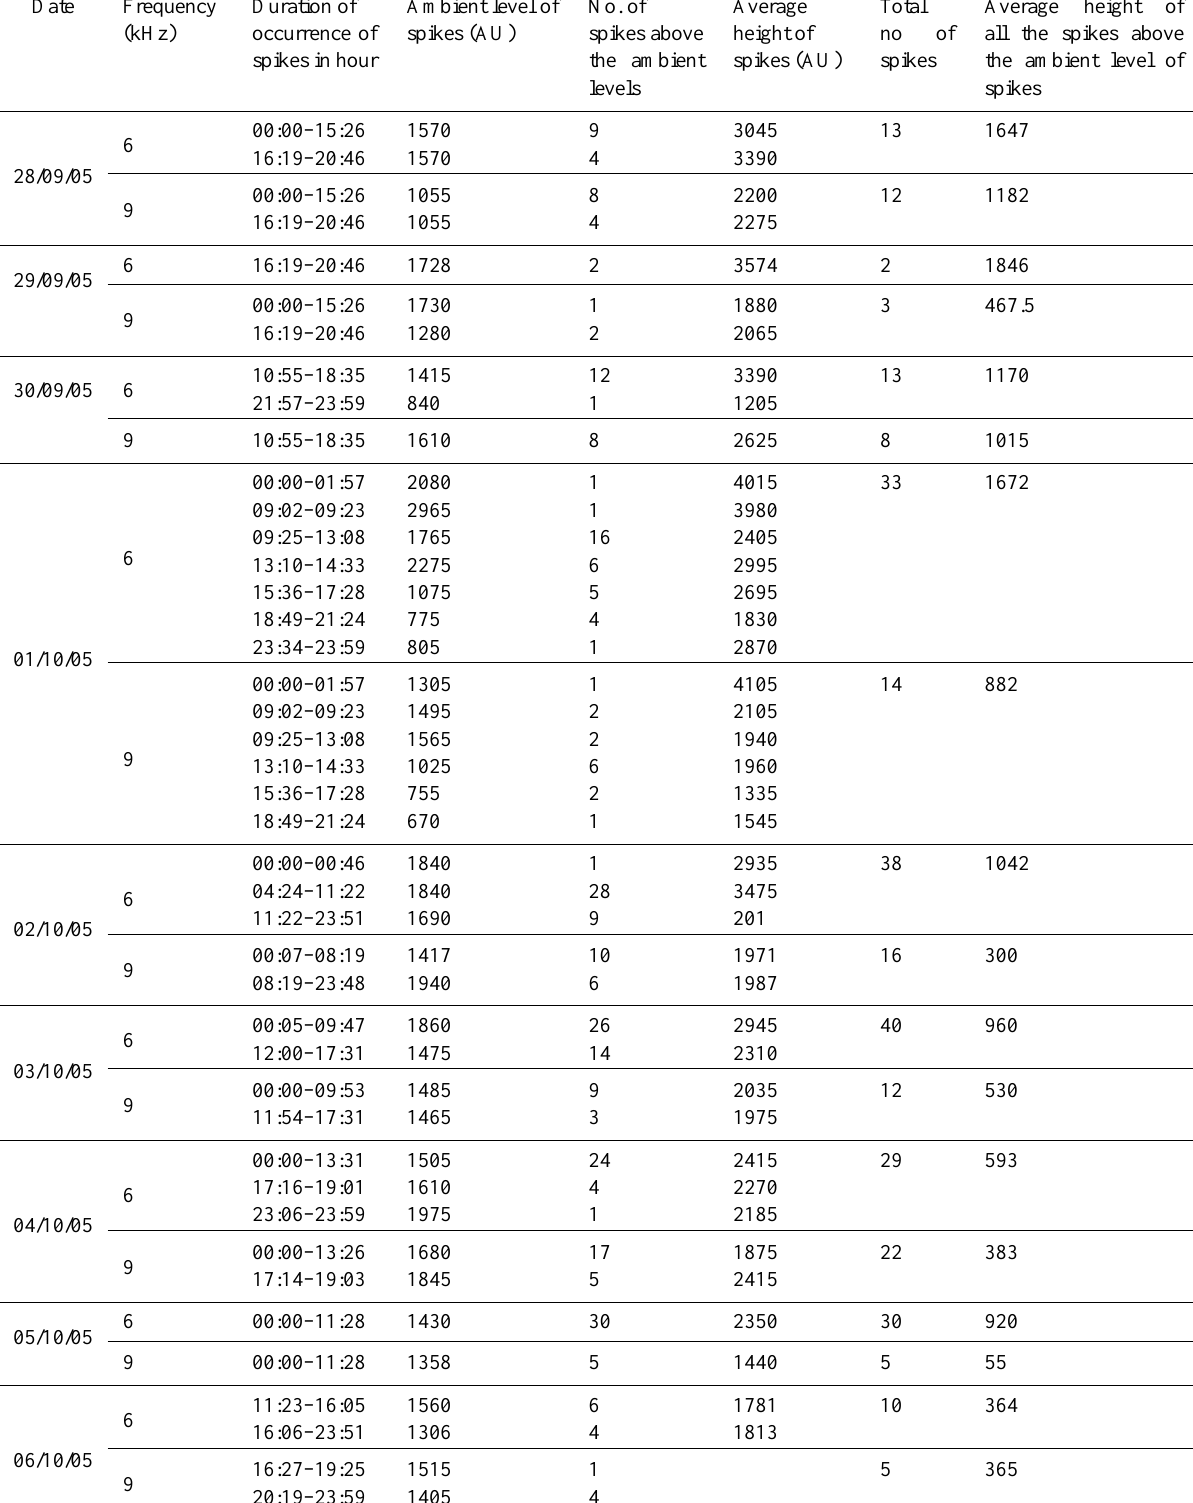
Table 2. Statistical analyses of different characteristic parameters of the earthquake from the recorded